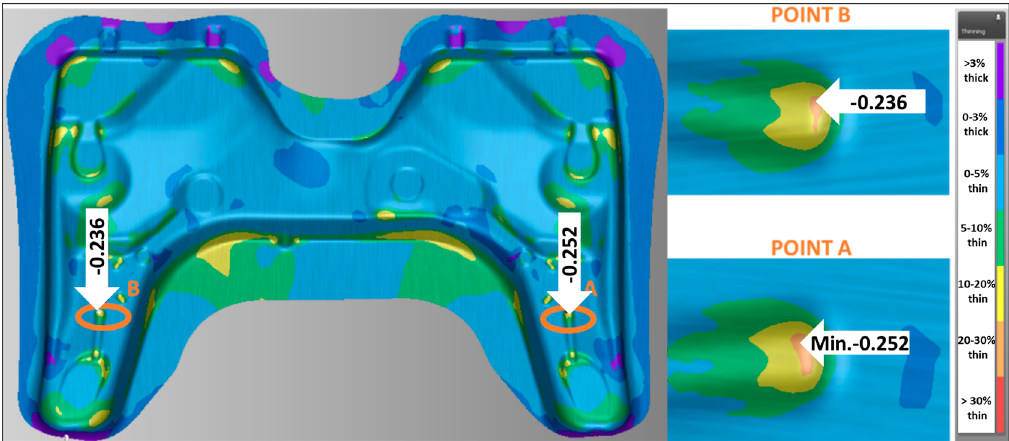
Figure 5. Critical Points A and B for the evaluation of thinning. The output variables were evaluated at the end of the drawing phase, before the trimming operation in order to optimize the drawing